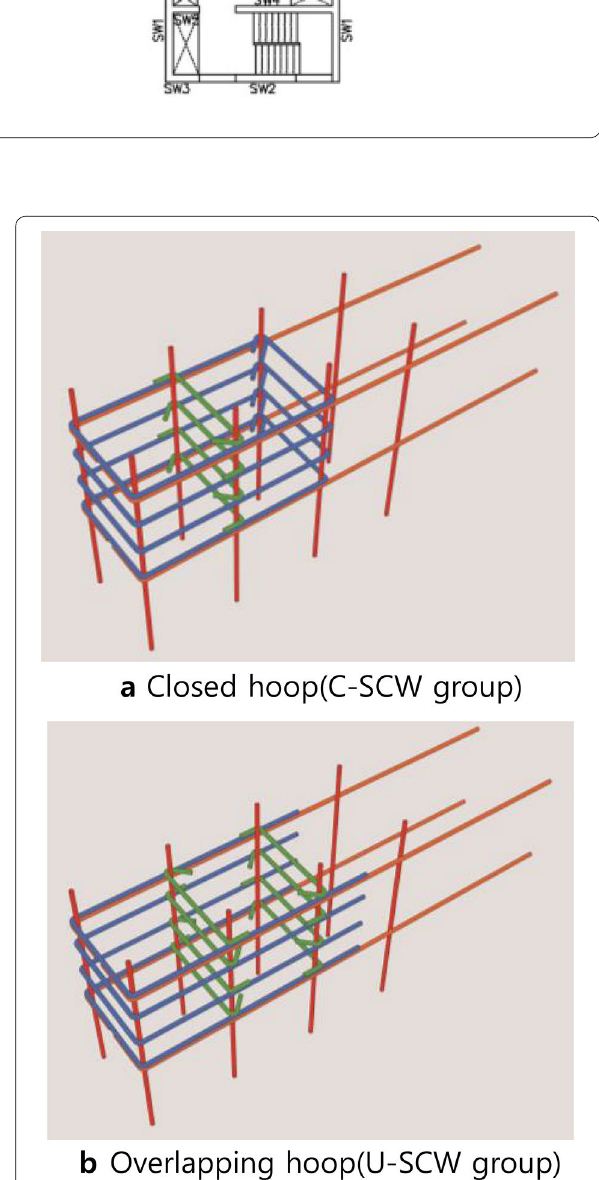
Fig. 3 Confinement detail of longitudinal